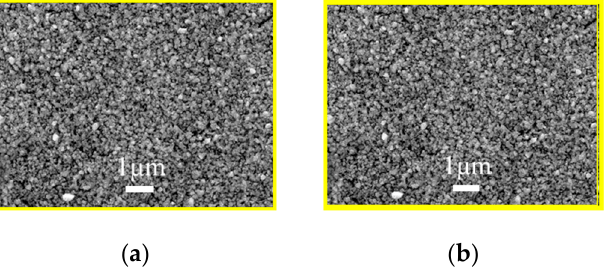
Figure 6. ( a ) Scanning electron microscopy surface morphology of the ( a ) AIGS precursor, and ( b ) cross-sectional micrograph of the AIGS precursor.